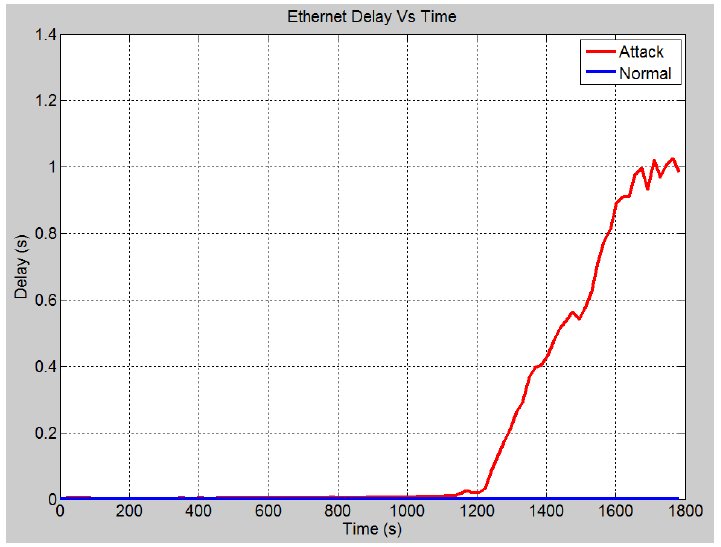
Sensors 2021 , 21 , x FOR PEER REVIEW Figure 14. Case 3: Global Ethernet delay (s) in no-attack scenario. Figure 14. Case 3: Global Ethernet delay (s) in no-attack scenario.